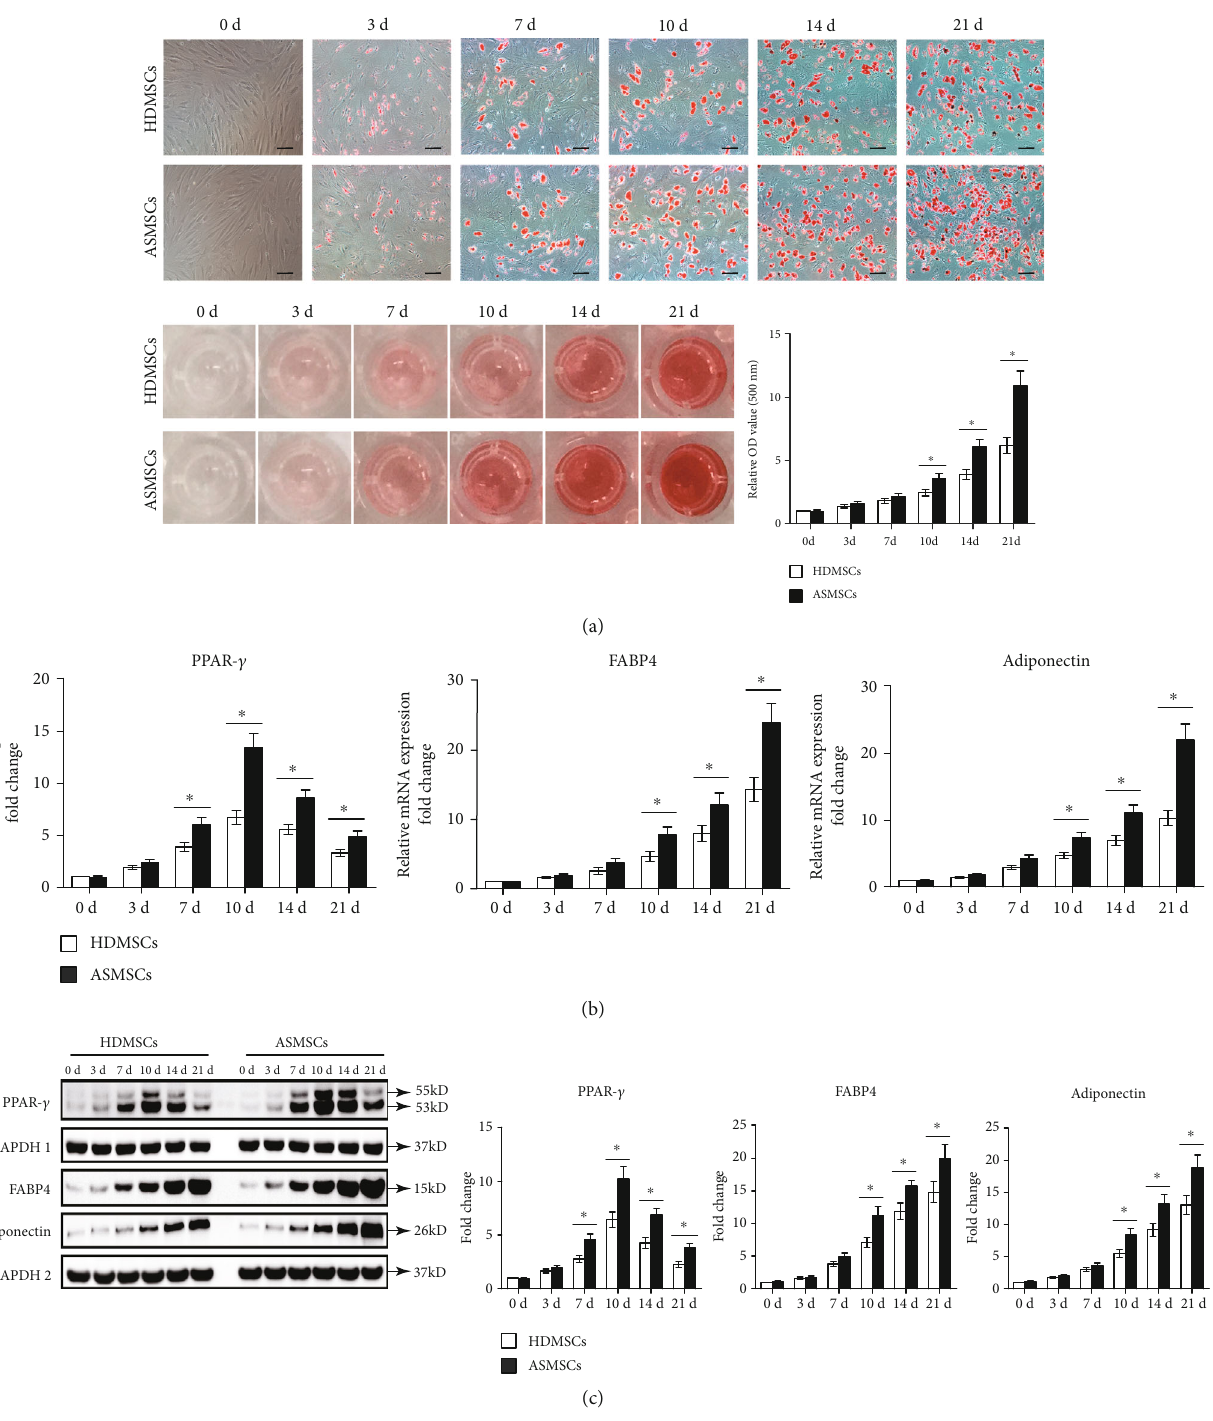
Figure 2: ASMSCs exhibited greater adipogenic di ff erentiation potential than HDMSCs. The adipogenic di ff erentiation capacities of HDMSCs ( n = 30 ) and ASMSCs ( n = 25 ) were determined using ORO staining and quanti fi cation and further con fi rmed by measuring the gene and protein expression of adipogenic markers, including PPAR- γ , adiponectin, and FABP4. (a) ORO staining was observed under a microscope (100x, black bars indicate 100 μ m), and images were captured. ASMSCs displayed darker staining than HDMSCs on days 10, 14, and 21. Consistent results were also observed for the quanti fi cation of ORO absorbance (500nm). (b) Higher expression of PPAR- γ mRNA was observed in ASMSCs than in HDMSCs on days 7, 10, 14, and 21. Moreover, higher levels of adiponectin and FABP4 mRNAs were observed in ASMSCs than in HDMSCs on days 10, 14, and 21. (c) The levels of the PPAR- γ , adiponectin, and FABP4 proteins were consistent with their mRNA levels. Together, these results suggested that ASMSCs had greater adipogenic di ff erentiation potential than HDMSCs. Values shown in (a – c) are presented as the means ± SDs . ∗ P < 0 : 05 for the di ff erences between HDMSCs and